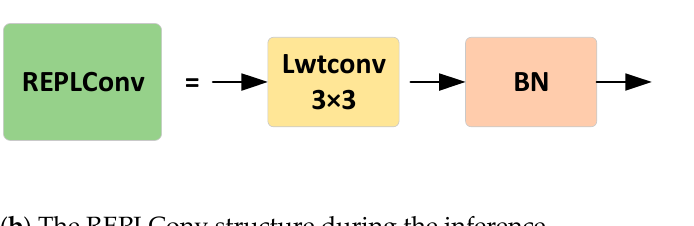
Figure 6. The structure of REPLConv.